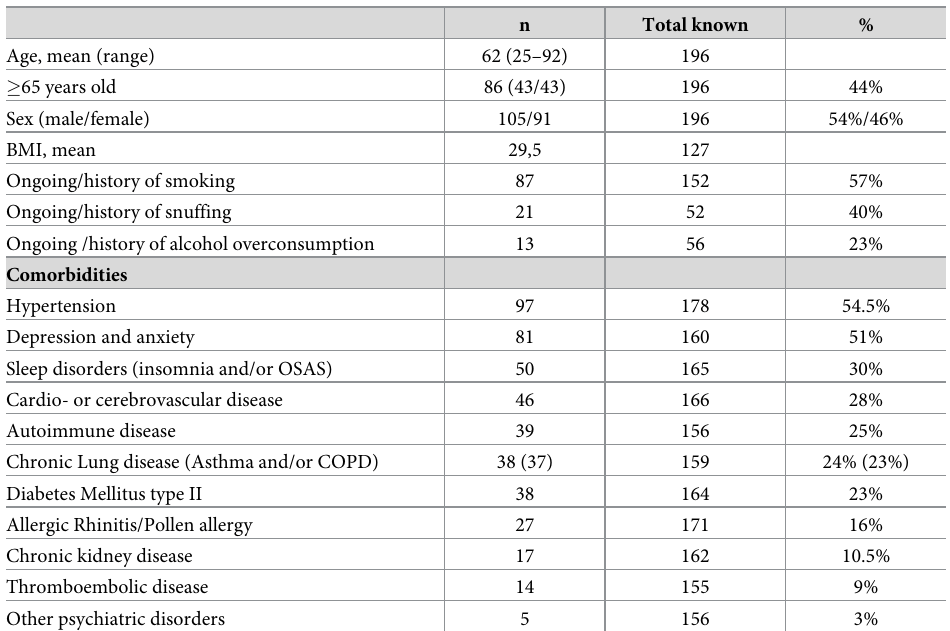
Table 2. Overall symptoms under first and/or second medical care seek. Variable n Total known % Hospitalization 175 196 89% Average of medical care period (days) 16 Average of days in Intensive Care Unit (days) 18 General symptoms Fever 177 184 96% Cough 167 184 91% Oxygen supply requirement 108 134 80% Dyspnea/shortness of breath 128 179 71.5% Gastrointestinal symptoms (nausea, vomiting or diarrhea) 94 181 52% Bacterial or fungal infections 59 160 37% Respiratory care 37 134 28% Coagulation disorder 17 188 9% Table 2 shows the symptoms during first and/or second medical care seek. “n” shows the number of patients who replied positive to the corresponding variable, “total known” represents the total number of patients who replied to the corresponding question and the column to the most right shows the percentage of occurrence of each variable in regard to the respective total known